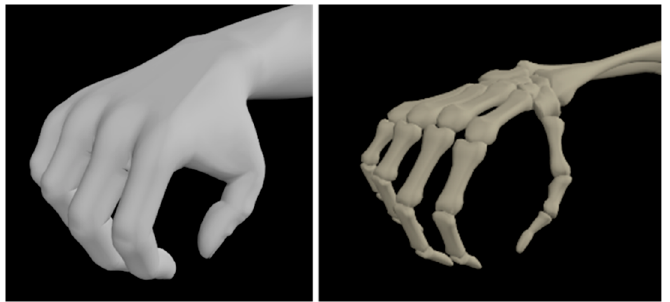
Figure 1. Outer surfaces of skin ( left ) and bones ( right ) at the initial hand posture.